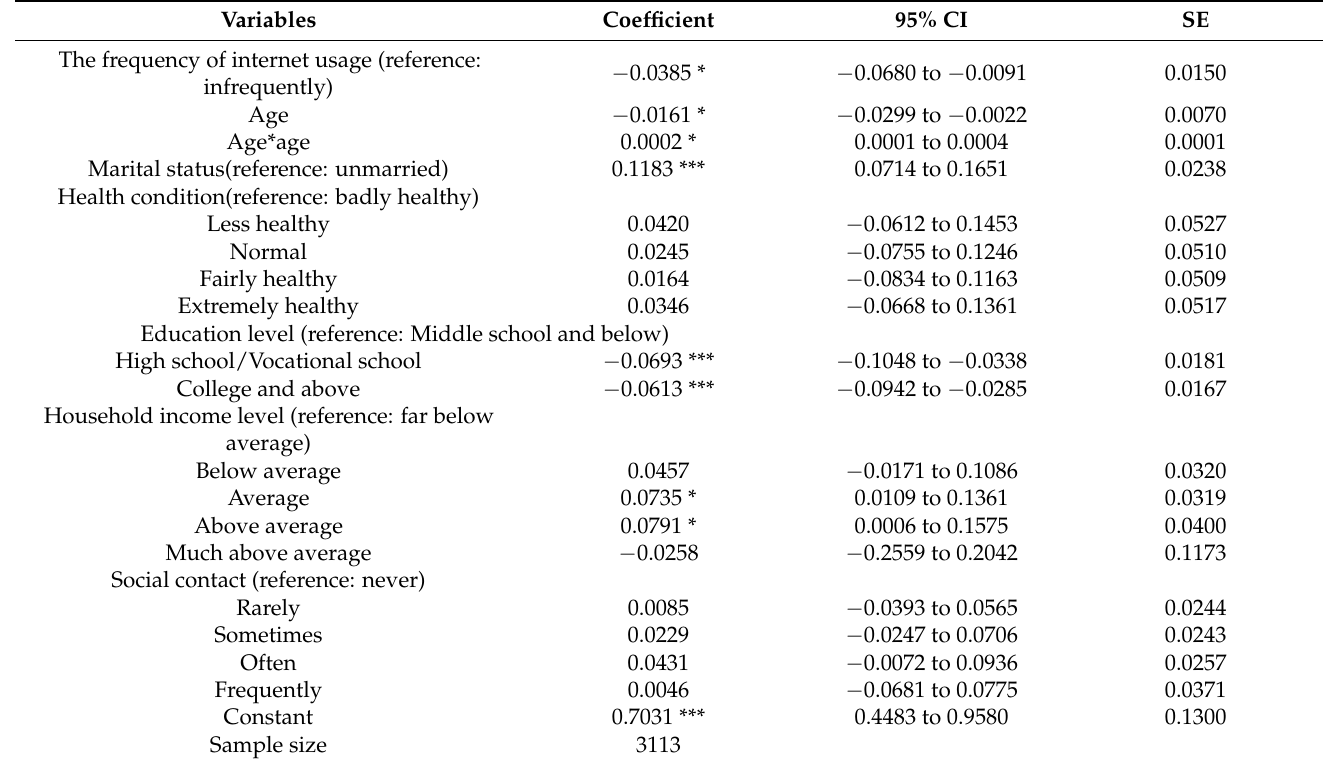
Table 2. Negative binomial regression analysis of internet usage frequency influencing fertility intention.